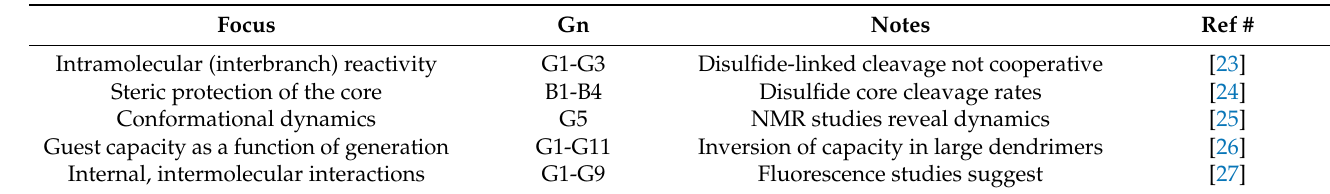
Table 3. Inquiries from physical organic chemistry.